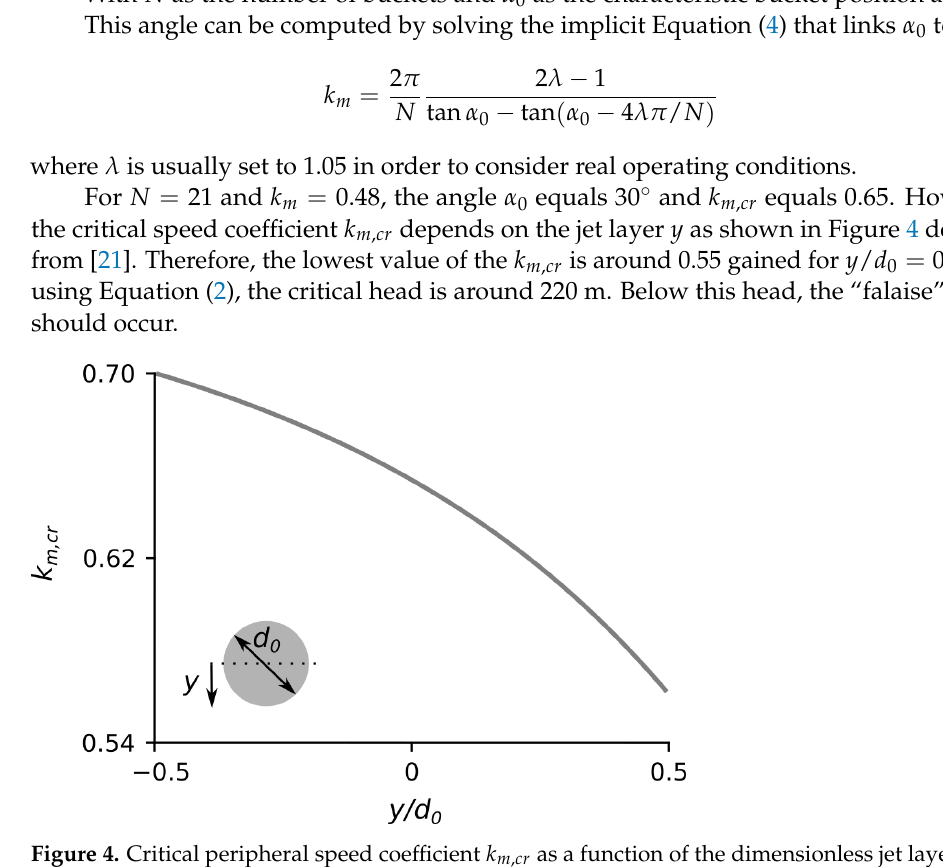
Figure 4. Critical peripheral speed coefficient k m , cr as a function of the dimensionless jet layer y / d 0 with d 0 as the jet diameter (see [21] for a detailed